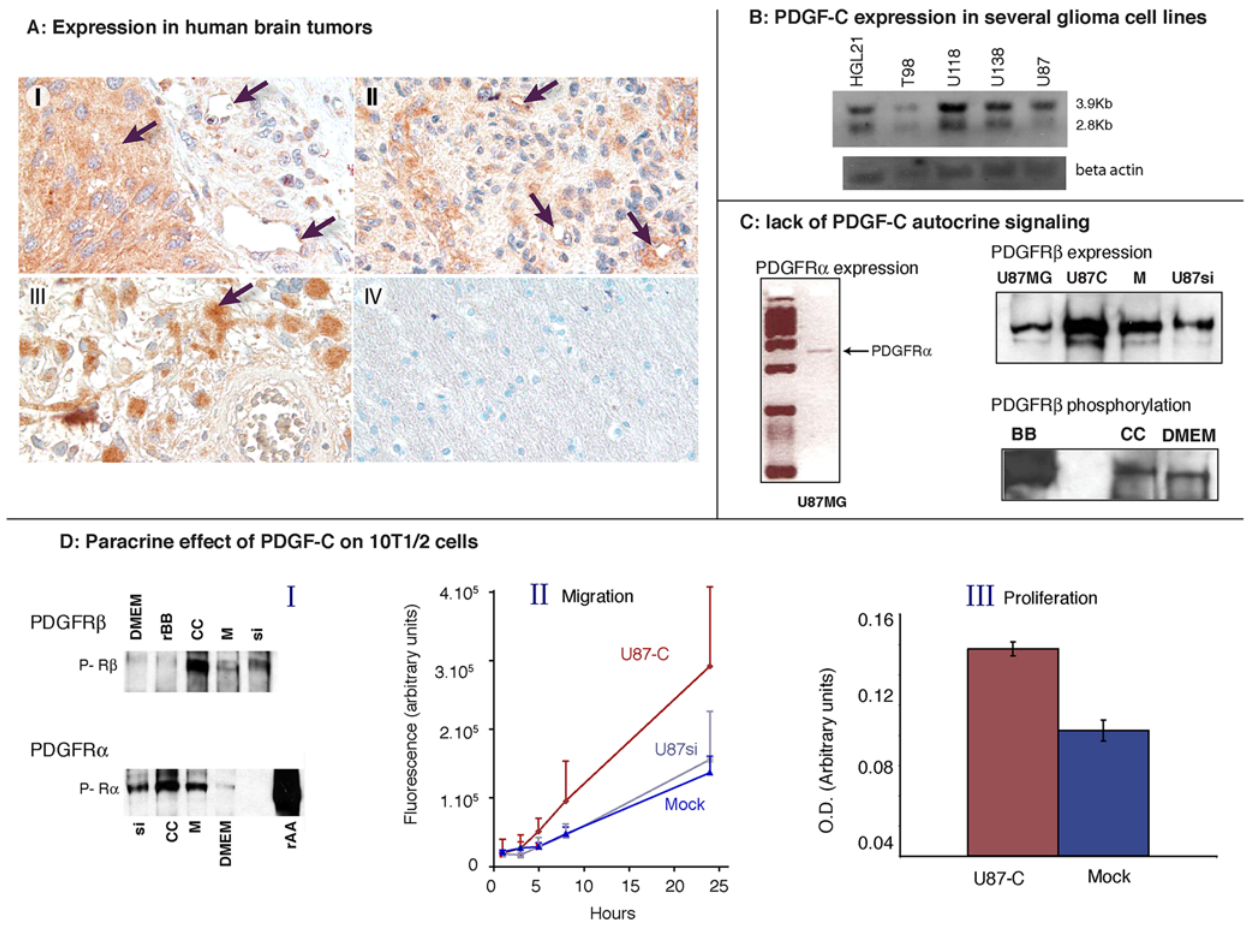
Figure 1. PDGF-C expression in human gliomas – autocrine & paracrine signaling. A: Expression of PDGF-C in human samples of gliomas. 27 samples of Grade IV glioma (Tissue Microarrays, kind gift from Dr. David Louis, MGH) were screened for expression of PDGF-C using immunohistochemistry (PDGF-C monoclonal antibody from R&D, used at 1/100). 23 out of 27 specimens expressed PDGF-C in tumor cells and/or in the peri-vascular area. Panels I, II and III are 3 different patients; panel IV is normal brain tissue present on the same array. In I and III positive